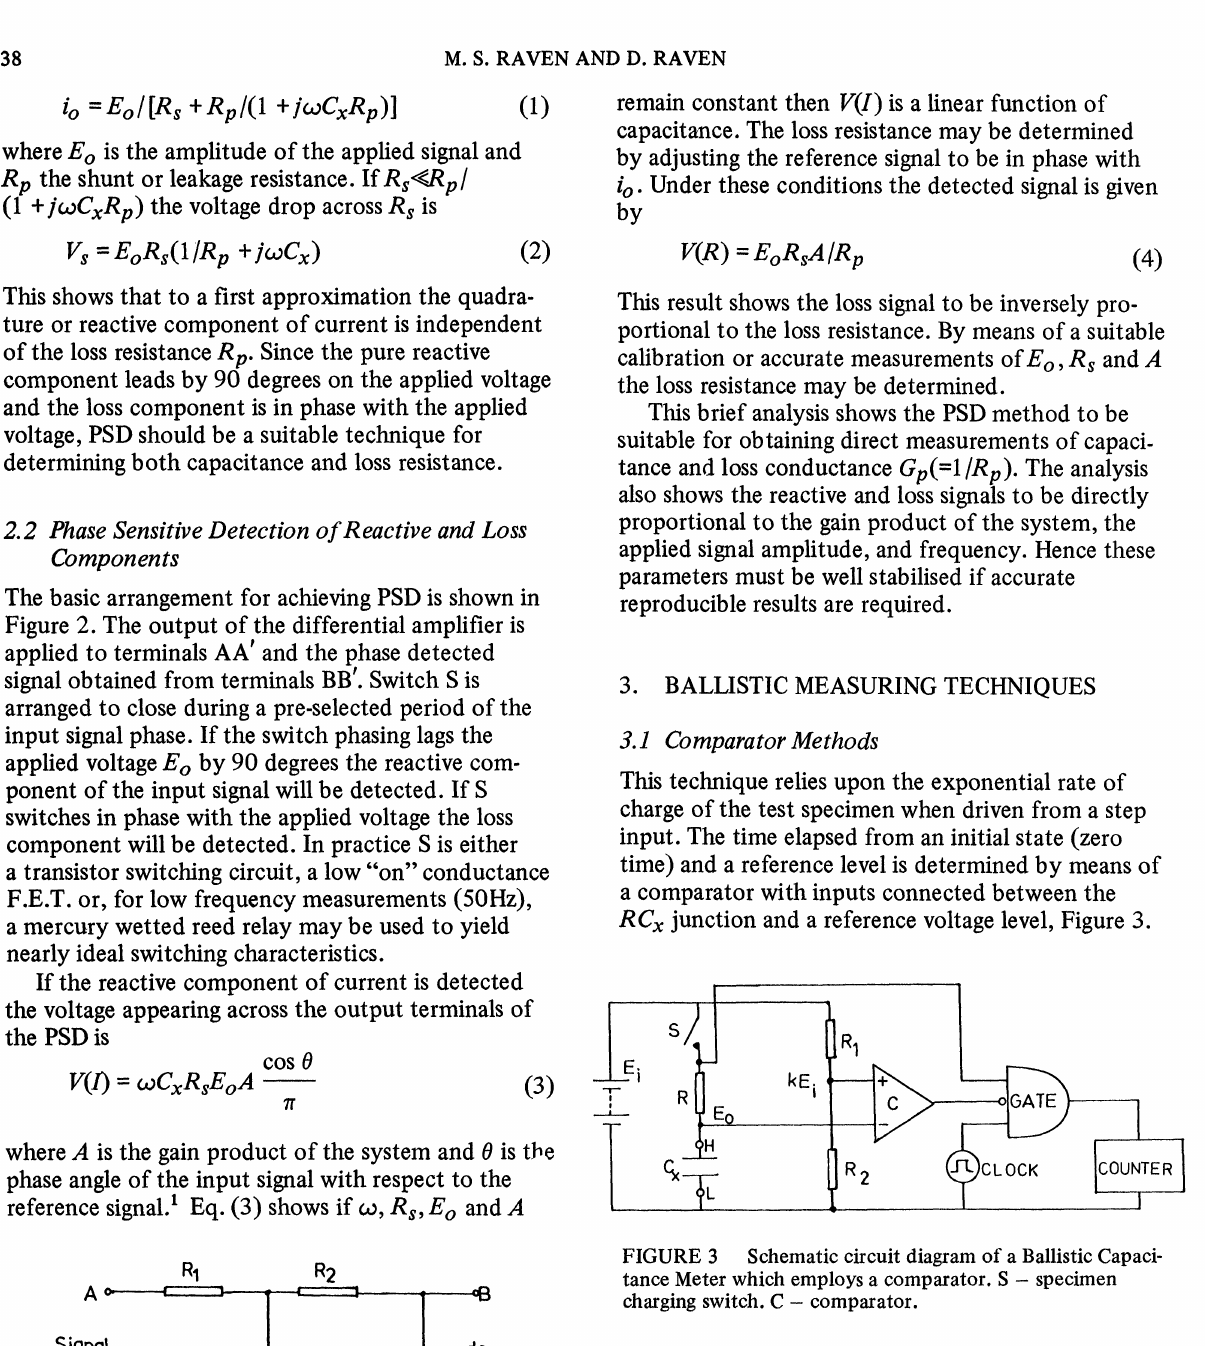
Basic circuit for phase sensitive detection. Switch S is operated by the reference phase. The signal from the main amplifier is applied to terminals AA’ and the d.c. output obtained from BB’.